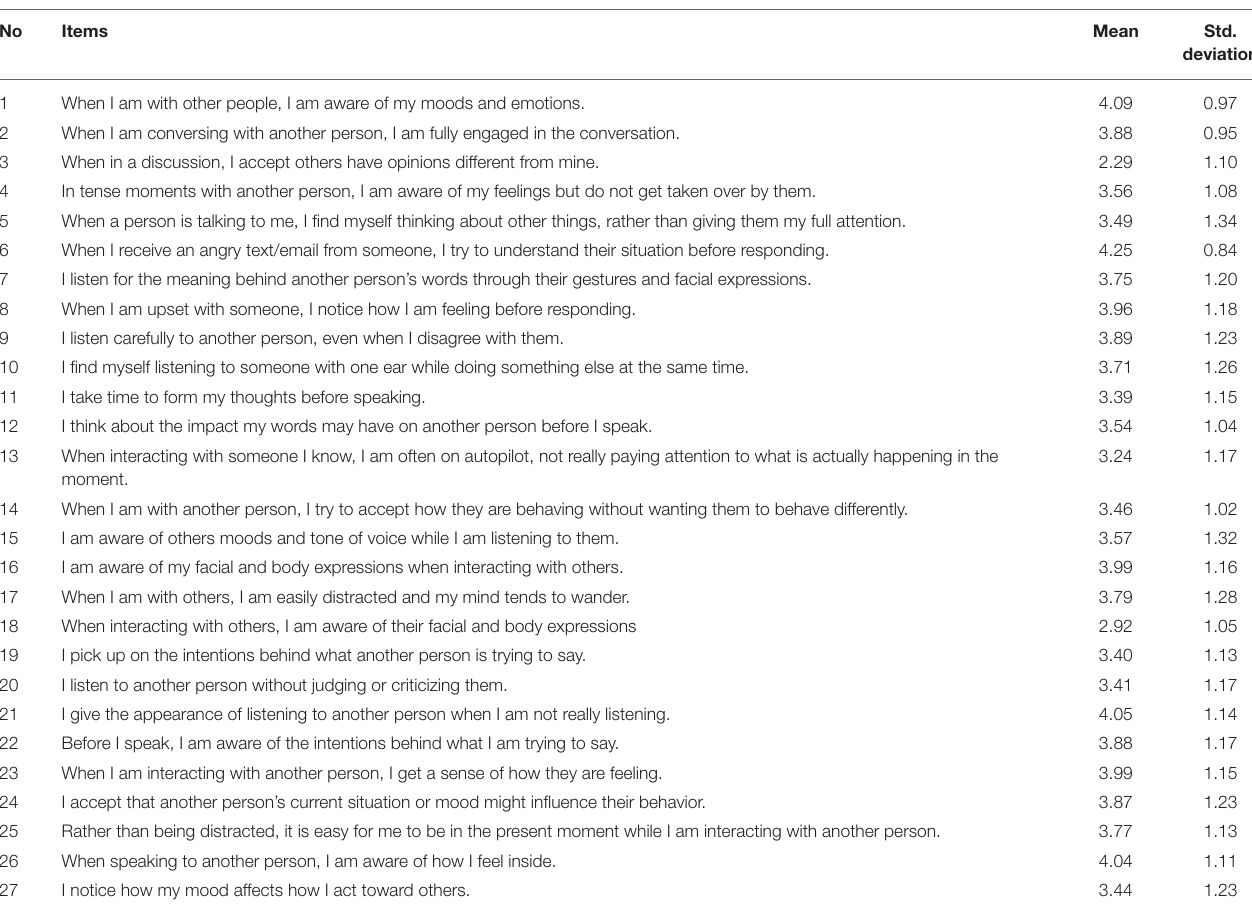
TABLE 2 | Means and standard deviations of the items of MIS. No Items Mean Std.